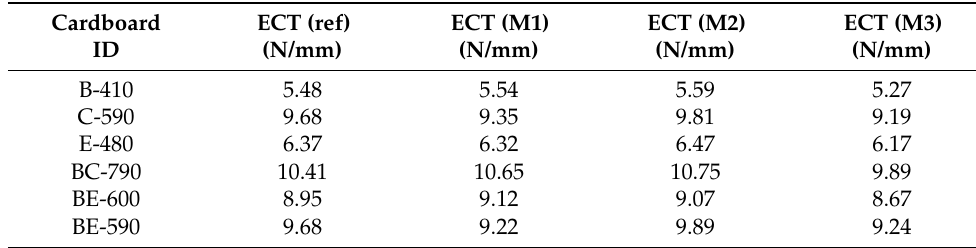
Table 6. Reference (measured) ECT values and estimation values with empirical–analytical and numerical models.